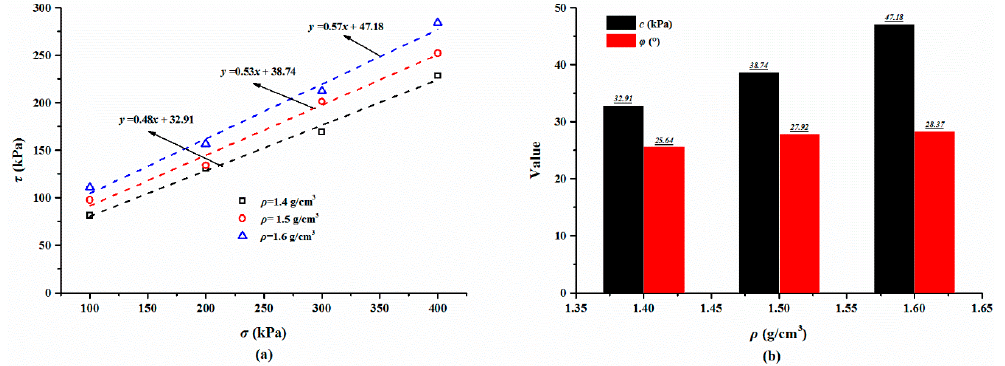
Figure 16. ( a ) The linear relationship between the shear strength τ and normal stress σ ; ( b ) The relationship between the shear strength parameters ( c and φ ) and the dry density ρ .